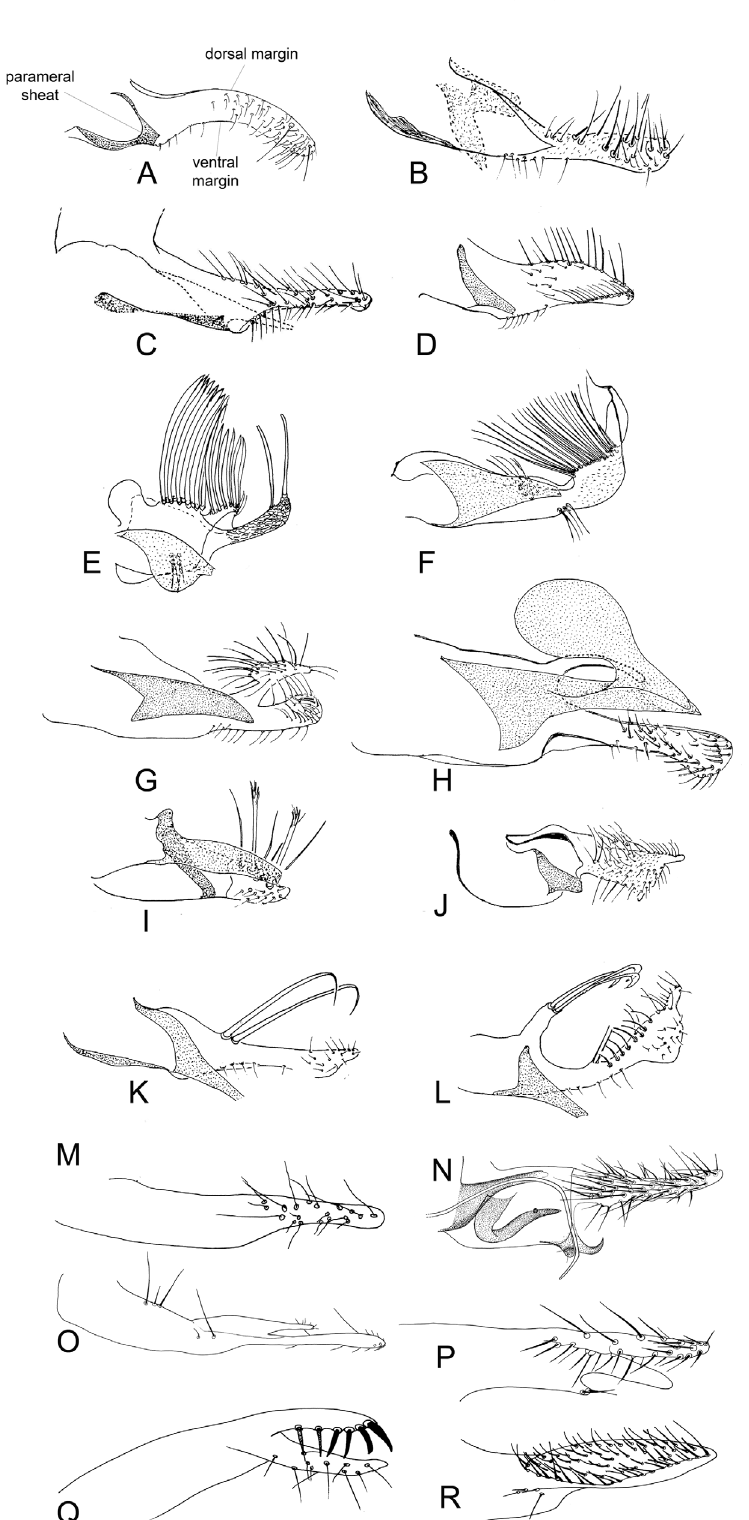
Figure 26. Lateral view of paramere and parameral sheath of Phlebotominae. (A) Migonemyia ( Blancasmyia ) gorbitzi ; (B) Evandromyia ( Aldamyia ) walkeri ; (C) Lutzomyia ( Helcocyrtomyia ) guderiani ; (D) Psathyromyia ( Psathyromyia ) lanei ; (E) Psychodopygus panamensis ; (F) Psychodopygus chagasi ; (G) Trichopygomyia longispina ; (H) Trichopygomyia dasypodogeton ; (I) Viannamyia tuberculata ; (J) Pressatia triacantha ;(K) Lutzomyia ( Lutzomyia ) longipalpis ; (L) Lutzomyia ( Lutzomyia ) dispar ; (M) Sergentomyia ( Sergentomyia ) dentate ; (N) Phlebotomus ( Legeromyia ) multihamatus ; (O) Idiophlebotomus padillarum ; (P) Phlebotomus ( Euphlebotomus ) barguesae ; (Q) Parvidens heishi ; (R) Phlebotomus ( Paraphlebotomus ) andrejevi